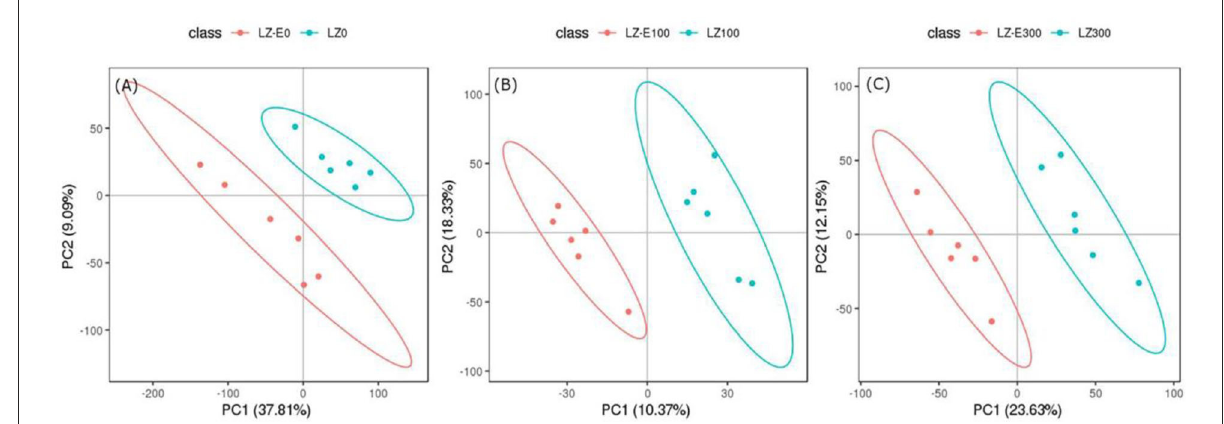
FIGURE5 Analysis of metabolites between E + barley and E– barley under salt stress conditions. PLS-DA analysis model score map. PCA score plot of metabolite analyses in barley samples for LC-MS data (A–C) . Red dots represent E. bromicola -inoculated barley at NaCl concentrations of 0, 100, and 300mM (LZ-E0, LZ-E100, LZ-E300), and the blue dots represent E. bromicola -free barley at NaCl concentrations of 0, 100, and 300mM (LZ0, LZ100, and LZ300). The horizontal axis is the first PC, and the vertical axis is the second PC. The number within parentheses is the score of